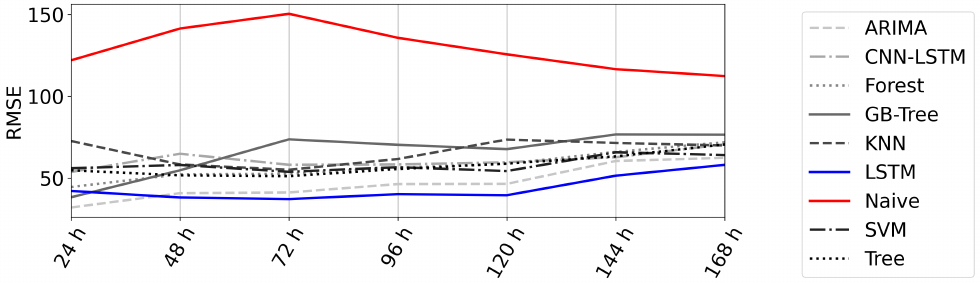
Figure 7. Model comparison over time for test scenario